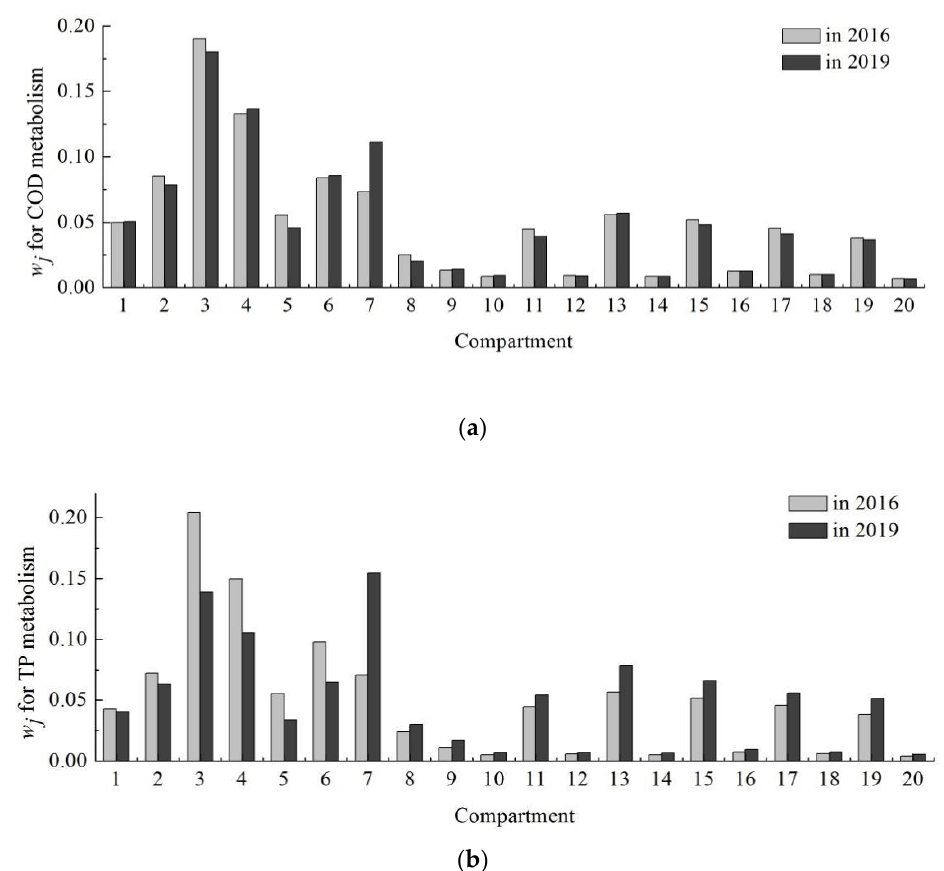
Figure 6. Contribution weight of each compartment in 2016 and 2019 in Fuzhou: ( a ) w j for COD metabolism; ( b ) w j for TP metabolism. metabolism; ( b ) w j for TP metabolism.